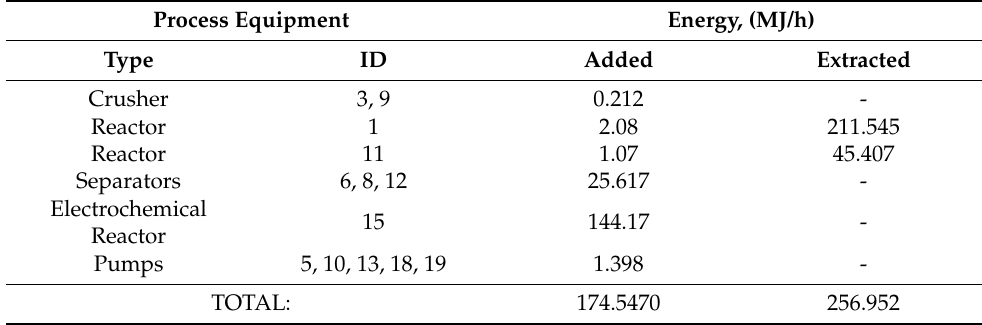
10 of 13 Table 11. Overall energy balance of the scaled-up dismantling process. Process Equipment